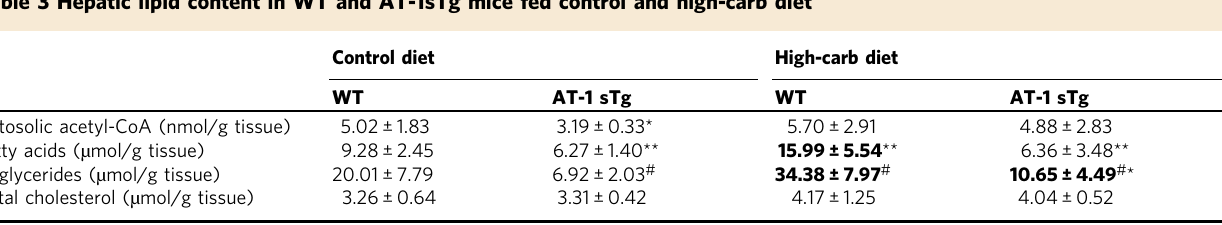
Table 3 Hepatic lipid content in WT and AT-1sTg mice fed control and high-carb diet